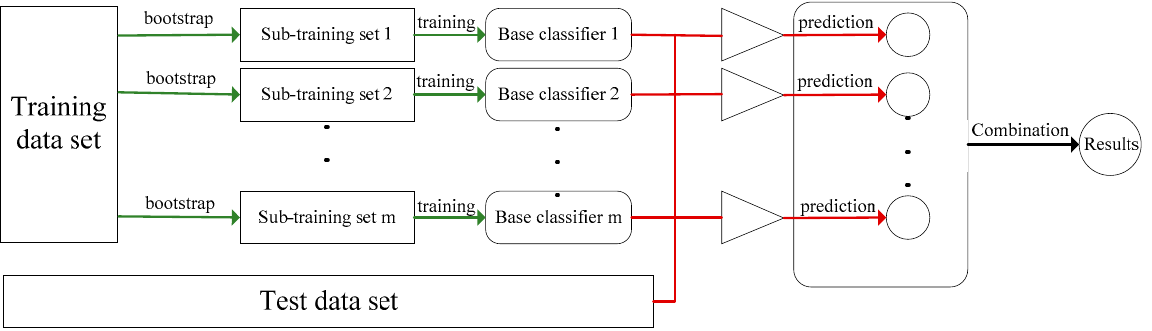
Figure 2. Structure of EL for transformer diagnosis based on DGA.